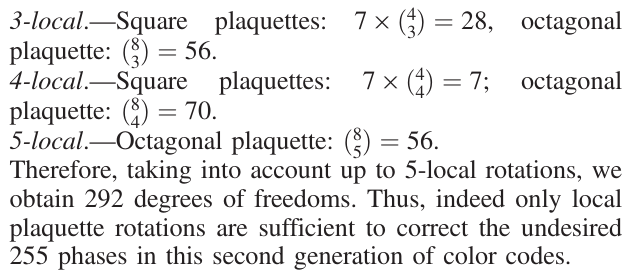
5-local . — Octagonal plaquette: ð 8